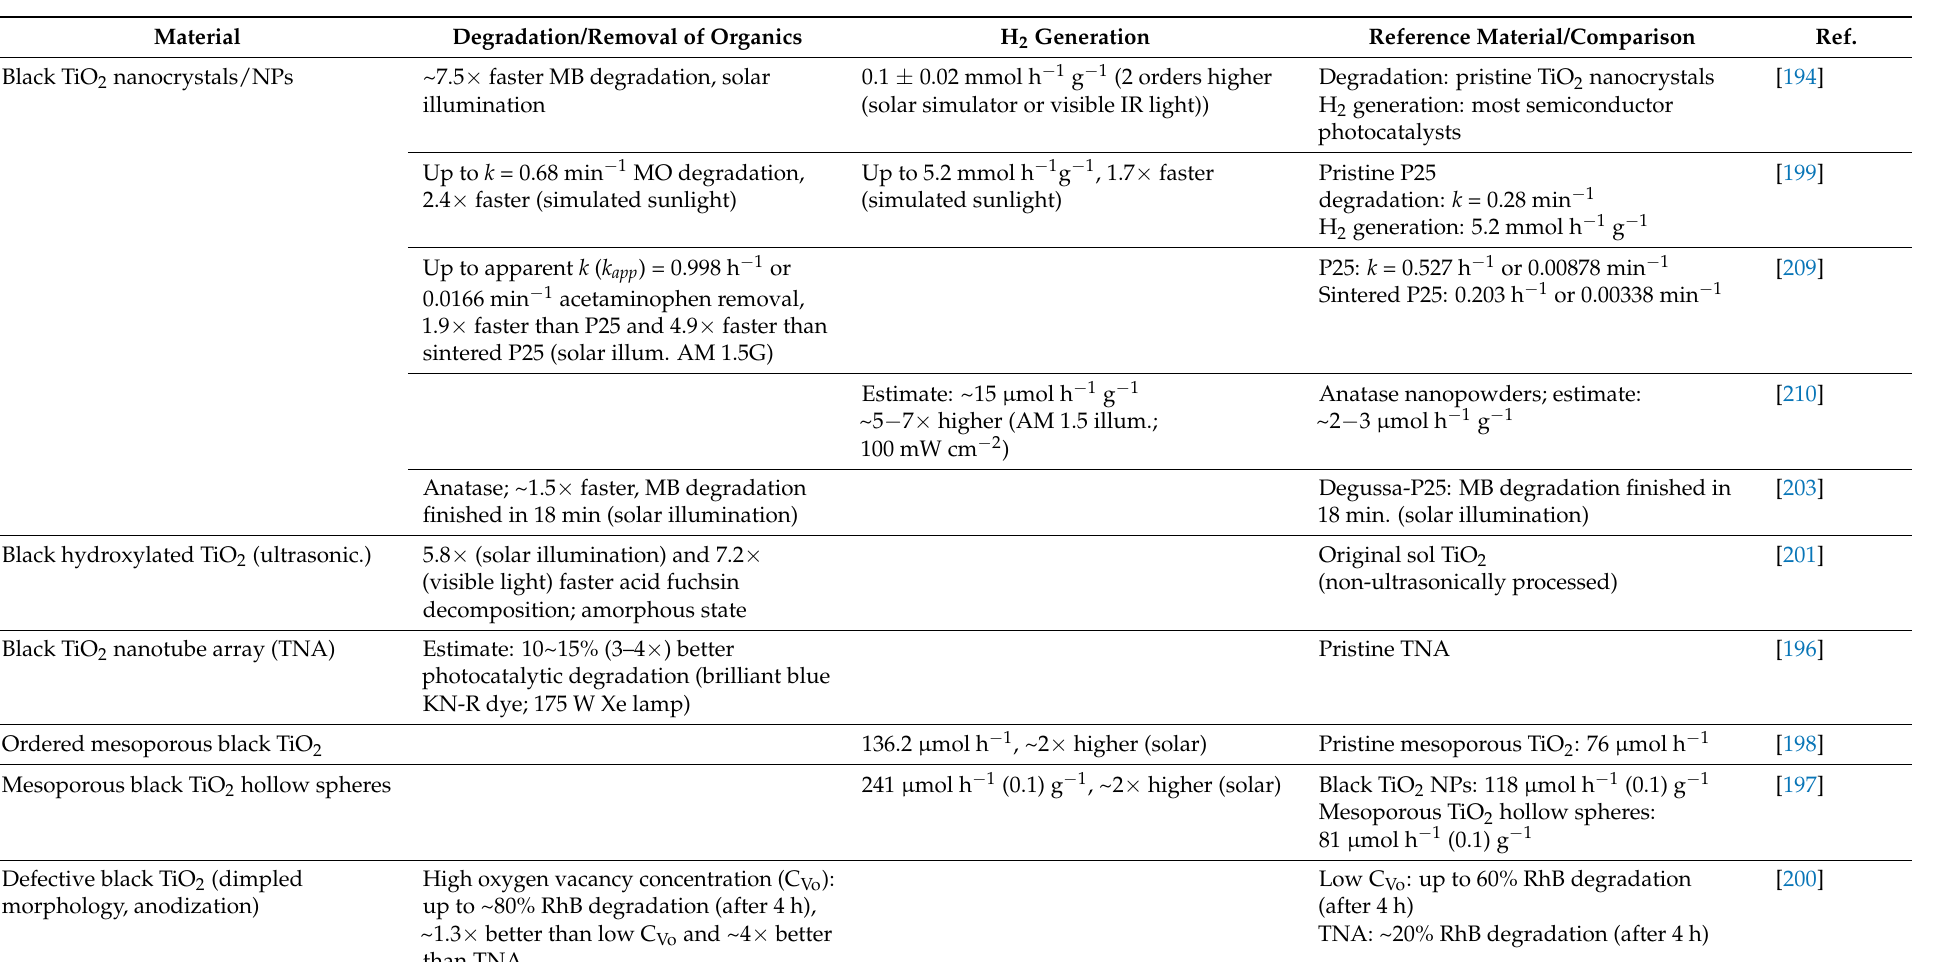
Table 2. Examples of black (and colored) TiO 2 nanomaterials and their photocatalytic performance in terms of degradation of organic compounds or hydrogen